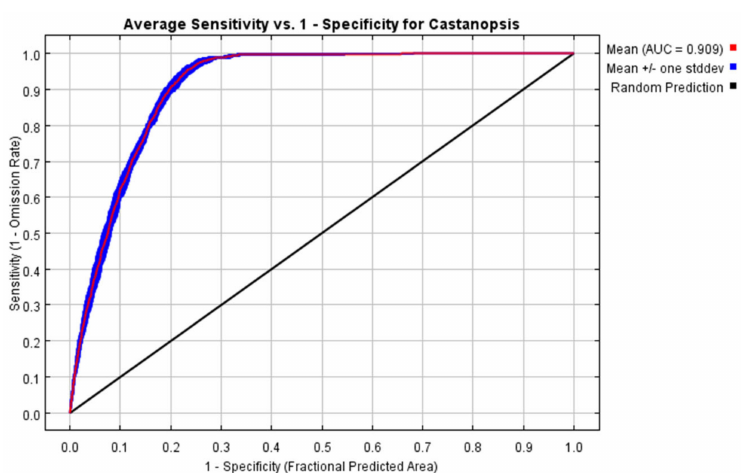
Figure 1. The subject operating characteristic curve generated by MaxEnt